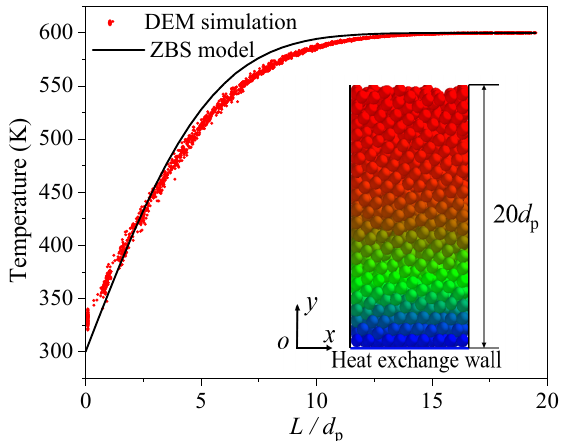
Figure 2. Comparison of temperature distribution with DEM simulation and ZBS model.